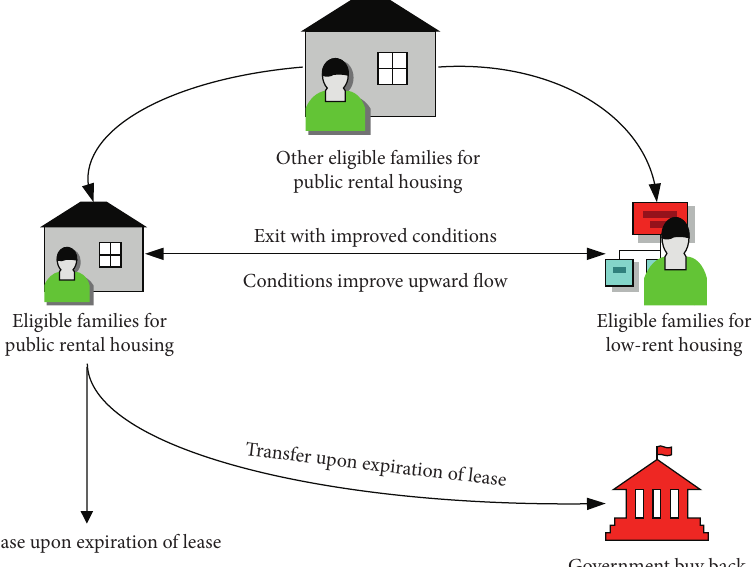
Figure 2: The circulation rules of public rental